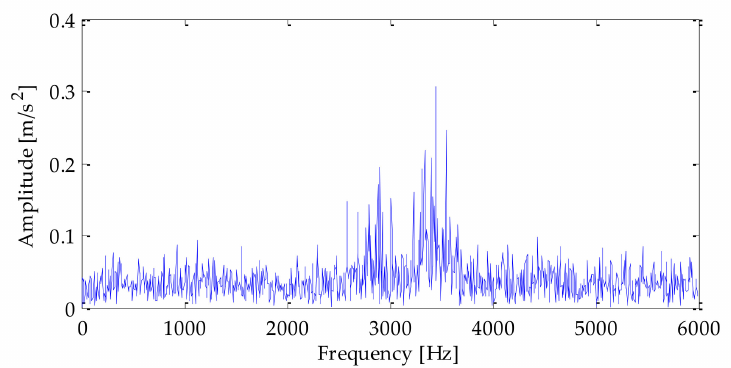
Figure 36. Frequency domain analysis of the mixed signal.